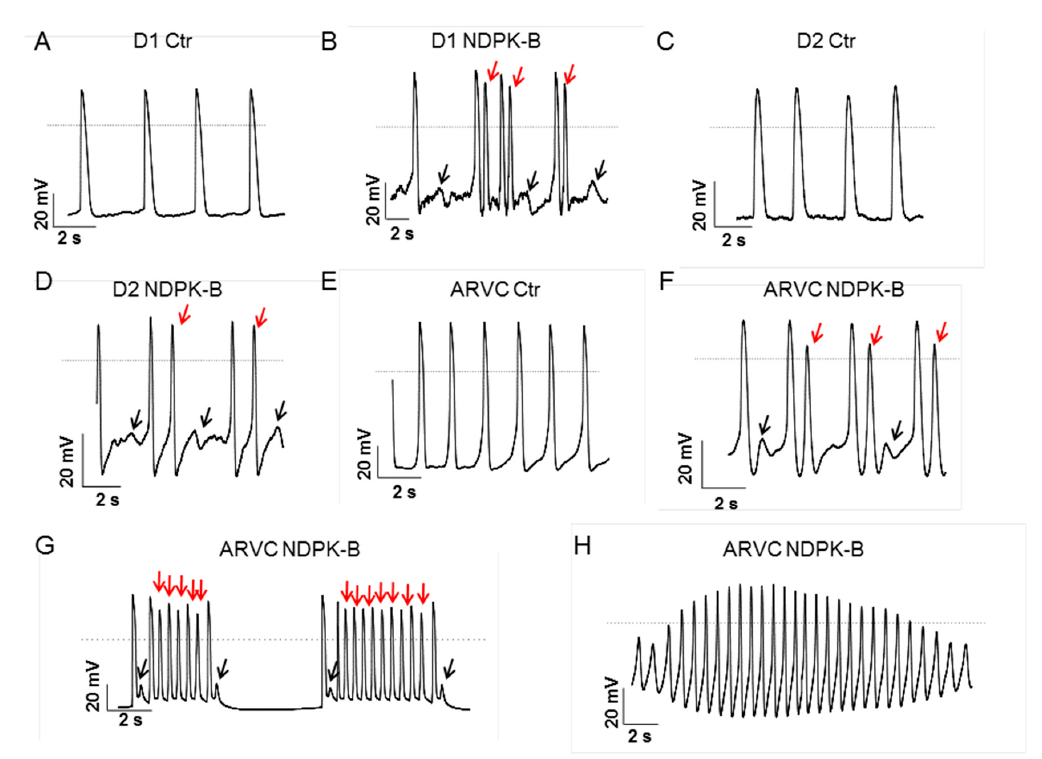
Figure 5. Recombinant NDPK-B induced di ff erent forms of arrhythmic events. Recombinant NDPK-B (30 ng / mL) was applied into healthy donor (D1, D2) or ARVC cells though the patch pipette. Spontaneous action potentials (sAPs) were measured in donor and ARVC cells. NDPK-B induced delayed afterdepolarizations (DADs, black arrows) or triggered beats (red arrows). ( A , B ) Examples of sAPs in hiPSC-CMs from donor one (D1) without ( A , Ctr) and with NDPK-B ( B ) showing DADs and bigeminy-like arrhythmic evens. ( C , D ) Examples of sAPs in hiPSC-CMs from donor two (D2) without ( C , Ctr) and with NDPK-B ( D ) showing DADs and bigeminy-like arrhythmic evens. ( E , F ) Examples of sAPs in hiPSC-CMs from the ARVC-patient (ARVC) without ( E , Ctr) and with NDPK-B ( F ) showing DADs and bigeminy-like arrhythmic evens. ( G ) An example of sAPs in ARVC-hiPSC-CMs with NDPK-B showing sustained triggered activity. ( H ) An example of sAPs in ARVC-hiPSC-CMs with NDPK-B showing torsade de pointes-like arrhythmic events.